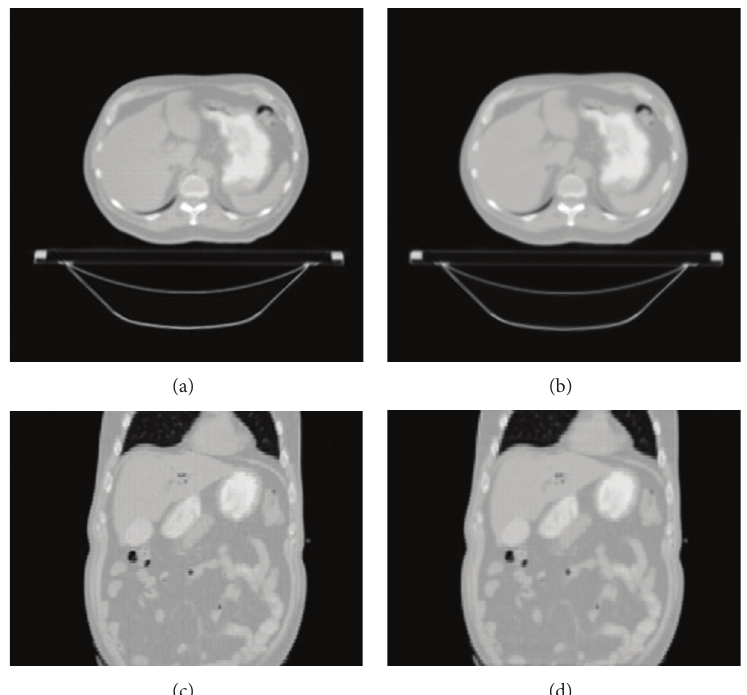
Figure 13: Transverse patient images reconstructed using the (a) FBP algorithm on data generated from fan beam geometry and the (b) SART algorithm from data generated using the dual source-dual detector geometry. Coronal images were also reconstructed using the (c) FBP and (d) SART